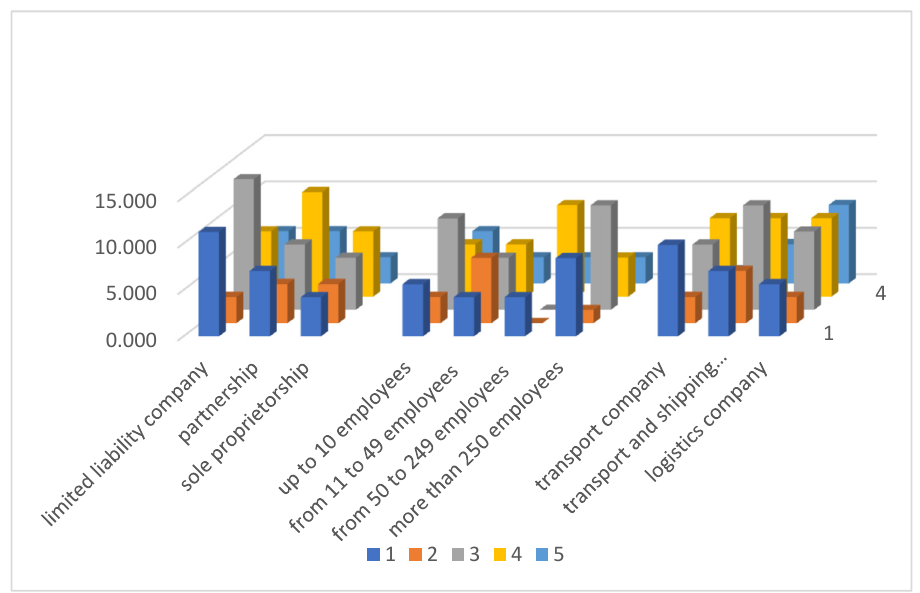
Figure 6. National economic situation and demand for electric vehicles—criteria organizational and legal form, employment structure, and scope of activity .